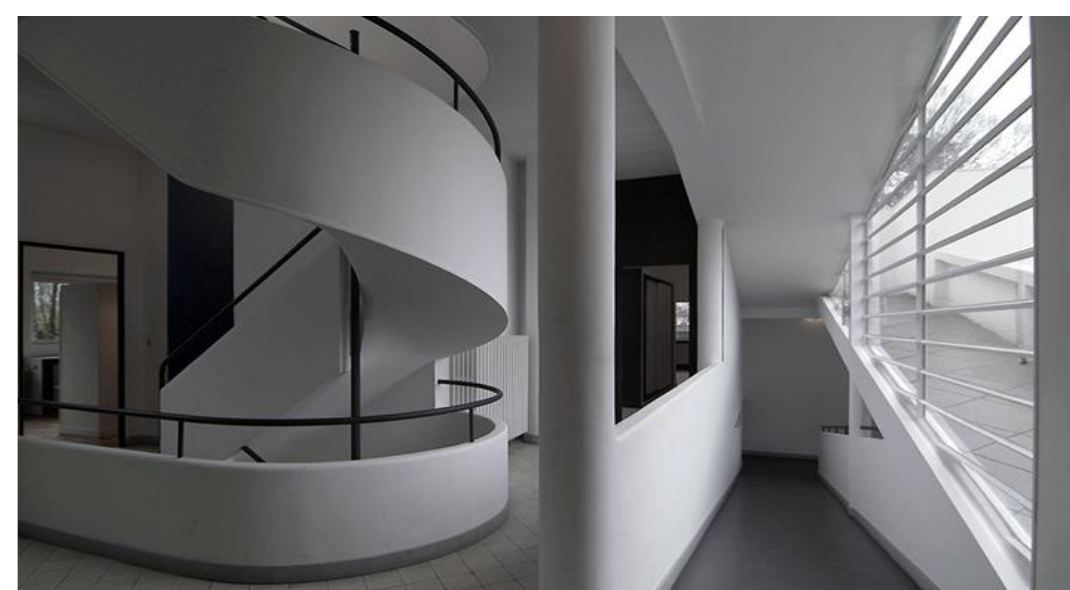
Figure 7. Interior view of Ramp and spiral staircase of Villa Savoye, Poissy, France [Source: